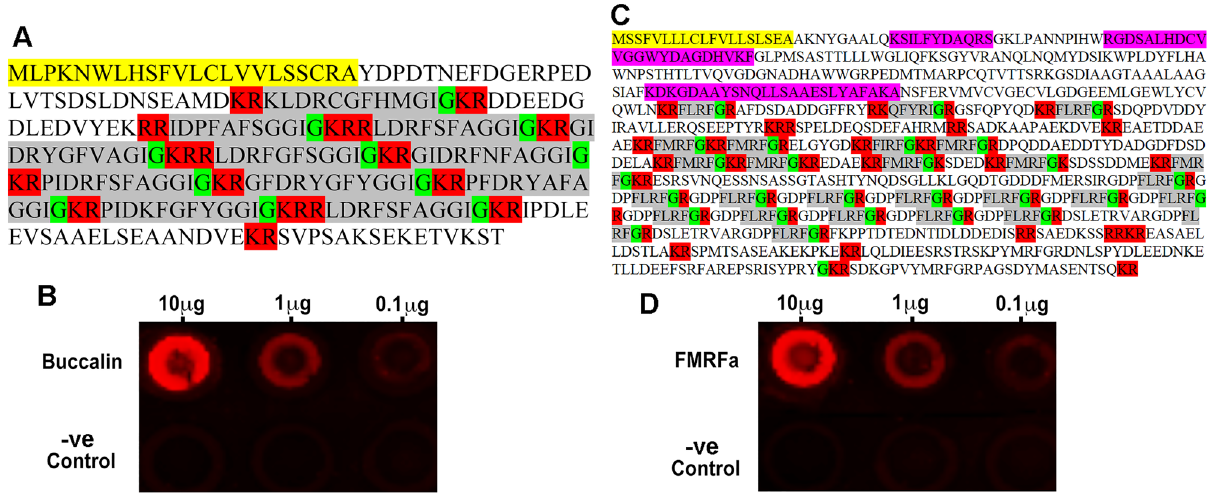
Figure 4. Biomphalaria glabrata precursor sequence and dot blot assay for buccalin and FMRFa in B. glabrata - conditioned water. ( A ) Buccalin neuropeptide precursor sequence ( B ) Dot blot using anti-buccalin on B. glabrata -conditioned water extracts at 10, 1 and 0.1 mg. ( C ) Buccalin neuropeptide precursor sequence. ( D ) Dot blot using anti-FMRFa on B. glabrata -conditioned water extracts at 10, 1 and 0.1 g µ . -ve Control represents purified water extract only. For precursor sequences, yellow—signal peptide, red—putative cleavage sites, green—amidation, grey—bioactive peptides, pink—MS peptide